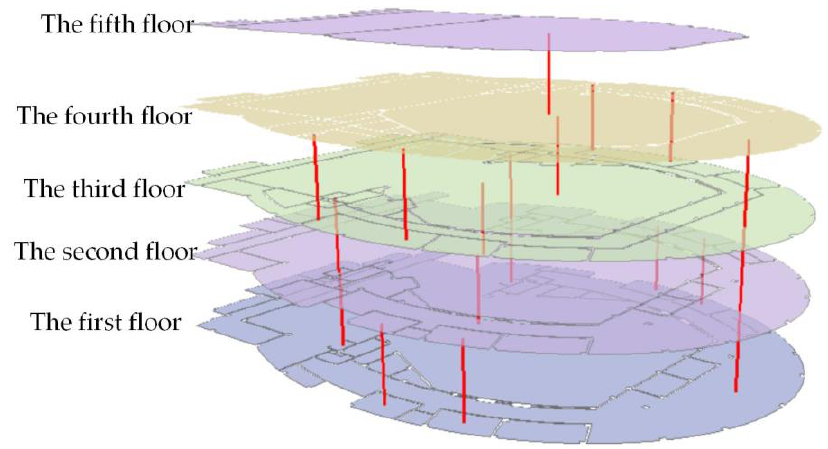
Figure 19. Connectivity relationships of indoor cross-floor spaces.